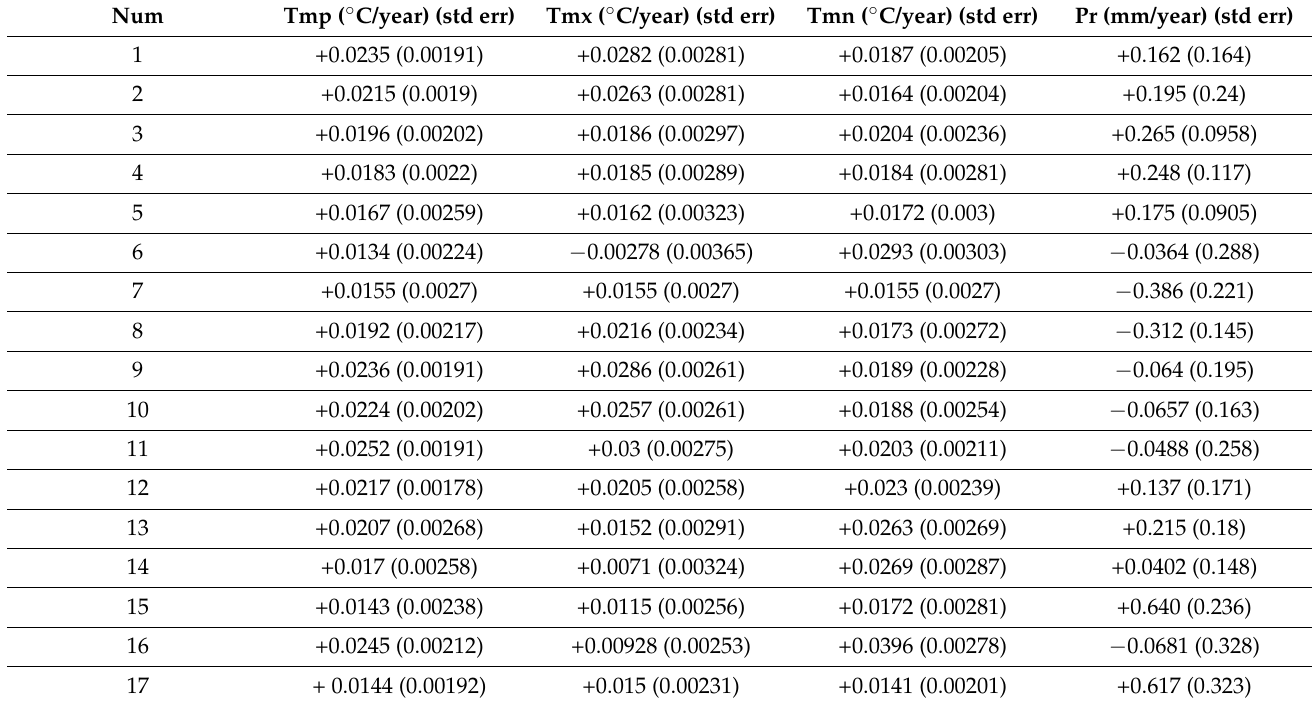
Table 3. Climate anomaly trends for the mean, maximum, and minimum temperatures and precipitation during 1960–2016. These trends correspond to the CRU